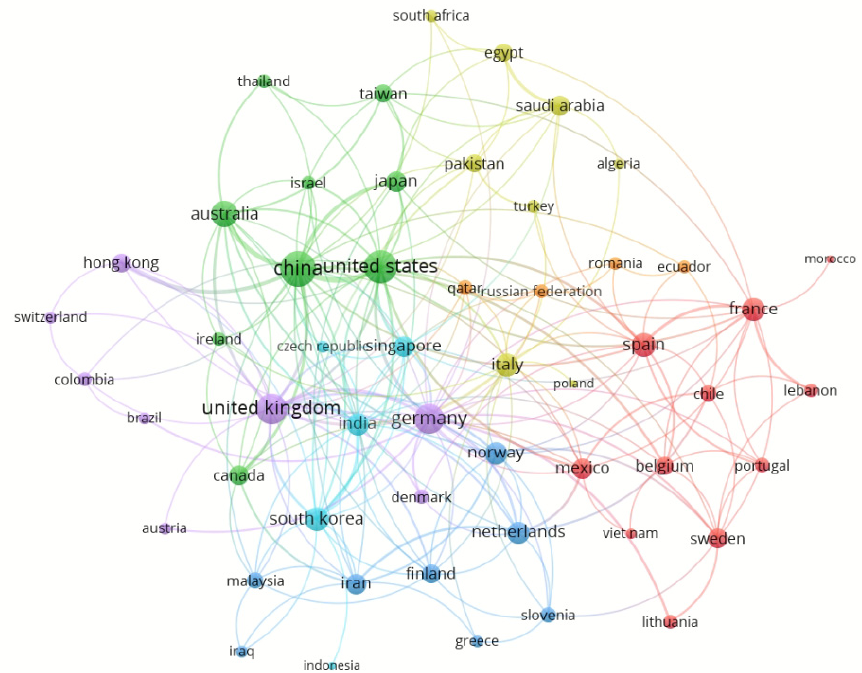
Figure 7. Co-authorship map. In this visualization the size of the item is related to the TLS of all the authors of the indicated country.